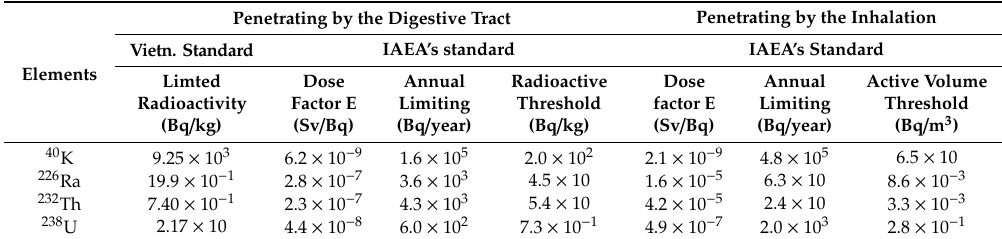
Table 8. Limiting radioactivity in the air, water, and